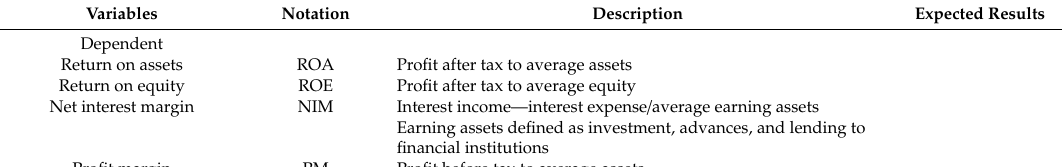
Table 1. List of